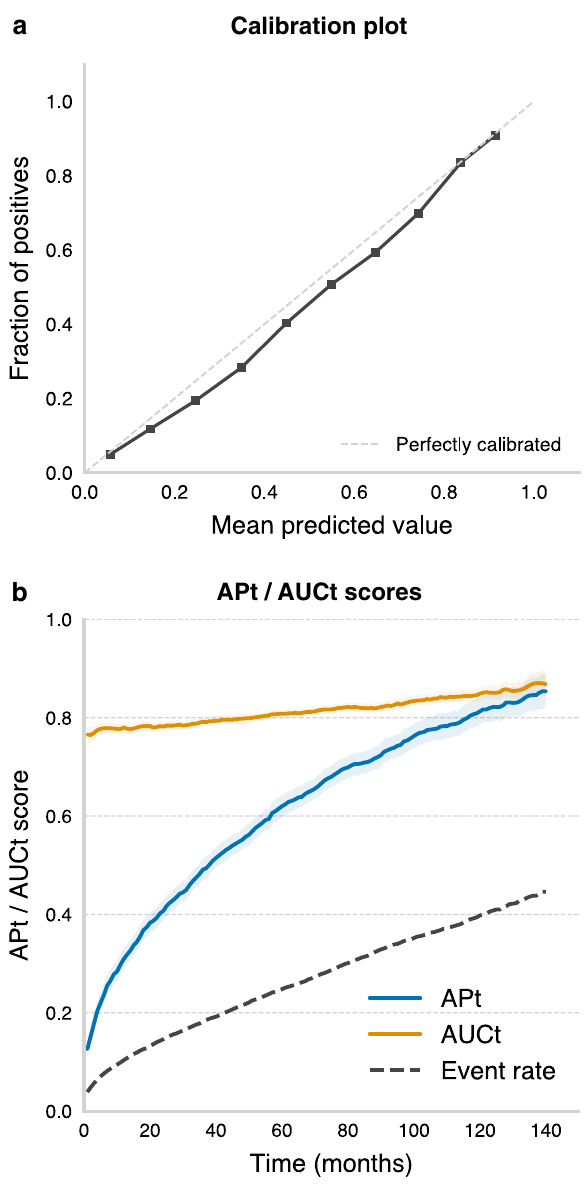
Fig. 4 Calibration and performance of the survival model. a Survival model calibration plot, as evaluated on the test set. b Time- dependent area under the curve (AUCt, yellow line) and average precision (APt, blue line) for the survival model, as evaluated on the test set. The event rate/chance level is represented by the dashed gray line. Shaded outlines represent 95% con fi dence